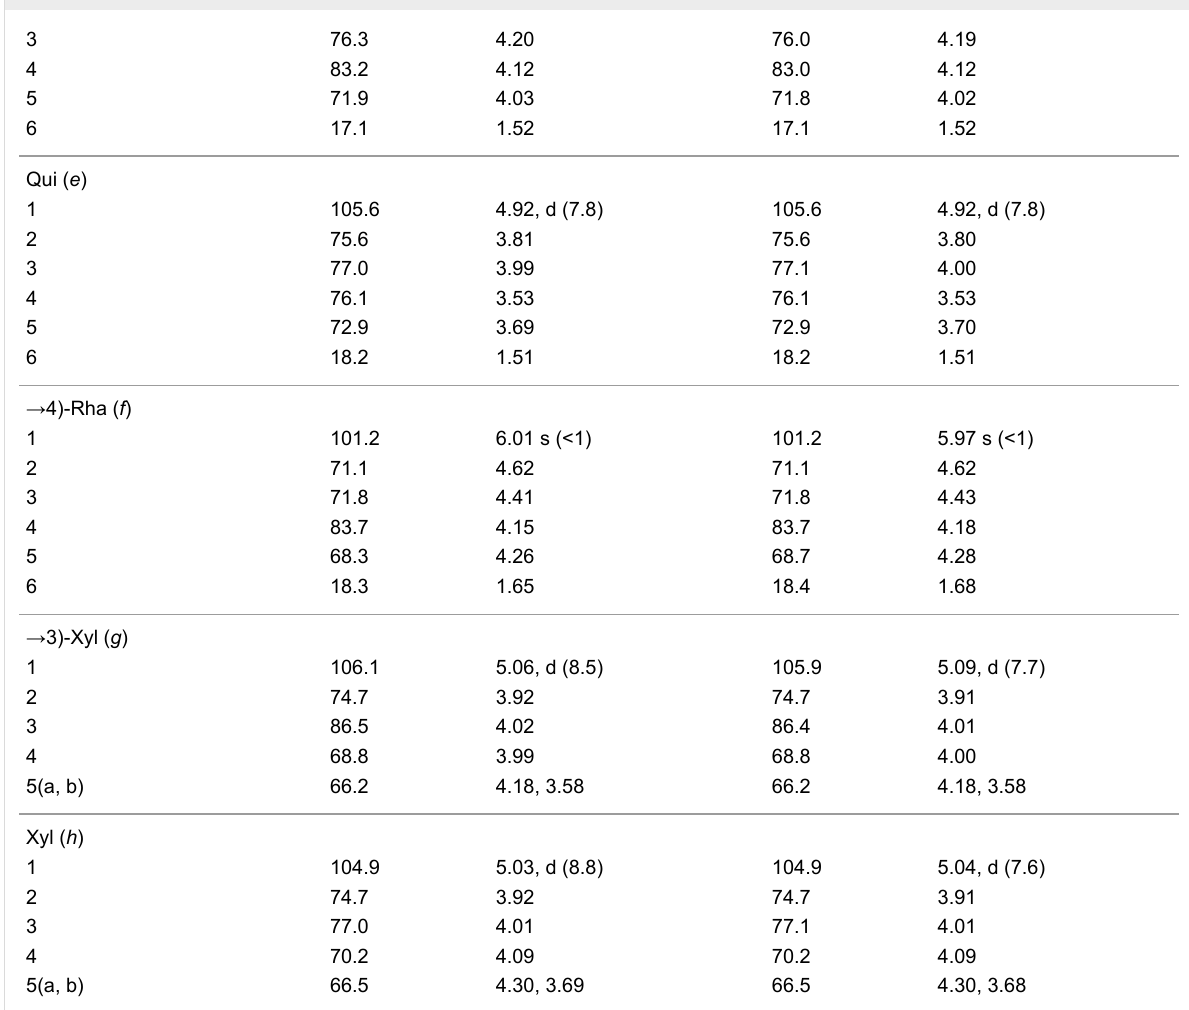
Table 2: 1 H and 13 С NMR data ( δ , ppm; J , Hz) for carbohydrate units of compounds 1 and 2 (500 MHz, pyridine- d 5 /D 2 O 1:1).